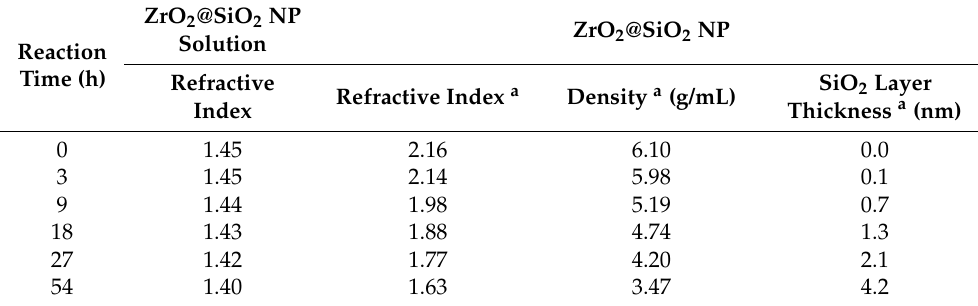
Table 1. Refractive indices measured from ZrO 2 @SiO 2 NP solutions with different reaction times and effective refractive indices, densities, and SiO 2 layer thicknesses calculated for ZrO 2 @SiO 2 NPs. All refractive indices are represented at the wavelength of λ = 633 nm (see Supplementary Materials for